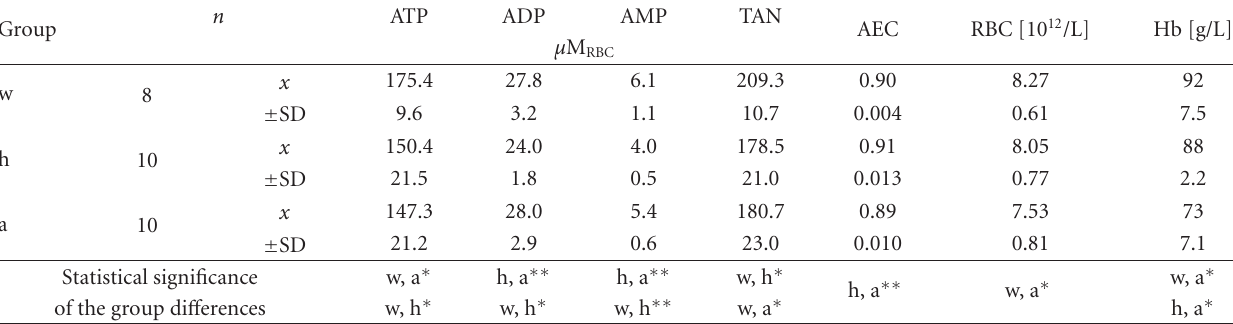
Table 2: Concentration of adenine nucleotides: ATP, ADP, AMP ( µ M), total adenylate nucleotide pool (TAN) and values of the adenylate energy charge (AEC) in erythrocytes of mares Wielkopolska breed (w), Hanoverian breed (h), Ardenian breed (a) Legend: x -mean; ± SD —